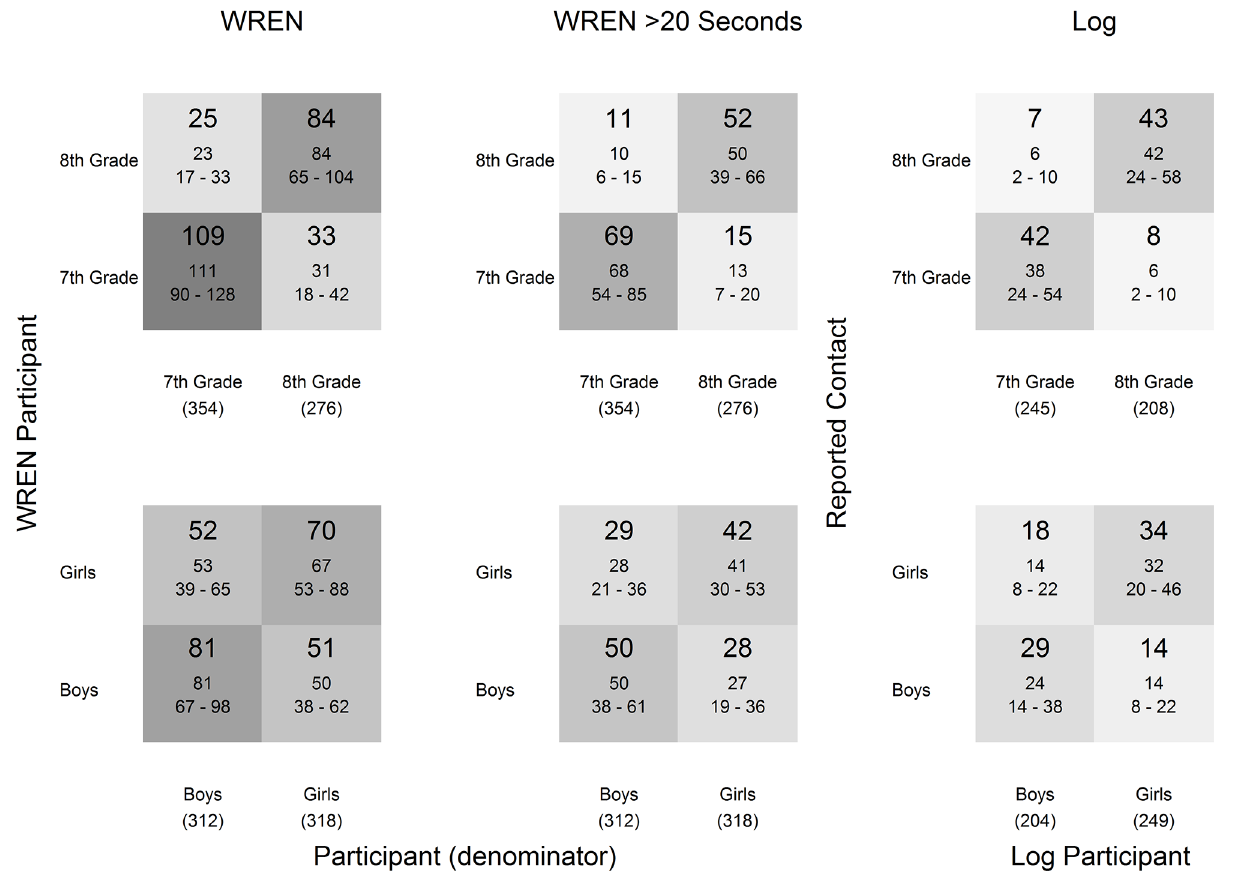
Fig 5. Contact matrices from observed WREN-recorded contacts (all durations and > 20 seconds) and Log-reported contacts using data from class period and lunch. The total contacts recorded between two groups are divided by the number of participants in the column group (given in parentheses) to provide an average number of contacts. Numbers per cell are mean (top), median, and interquartile range (25th and 75th percentile).